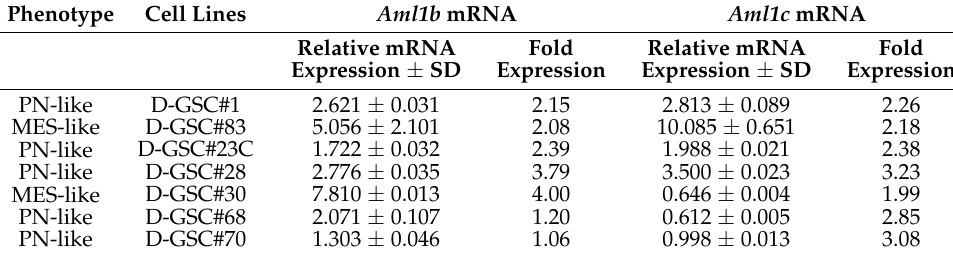
Table 3. Aml1b and Aml1c splice variants mRNA expression in D-GSCs.